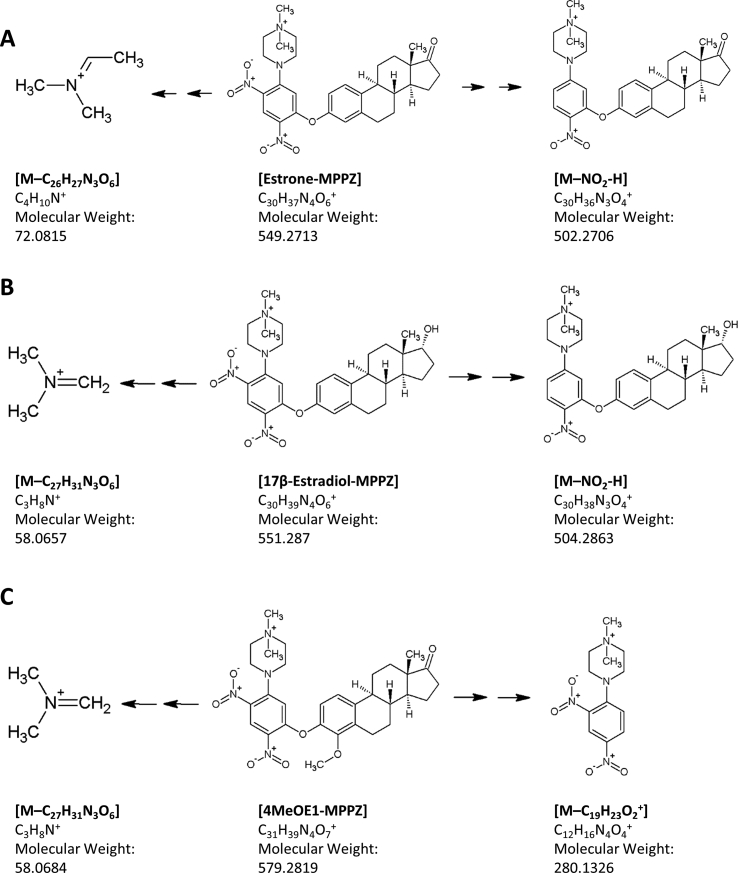
Proposed fragmentation patterns following accurate mass analysis at 1 μg mL−1 of estrogen methylpiperazine derivatives displaying common mass fragments; (A) Estrone (B) 17β- Estradiol (C) 4MeOEl.